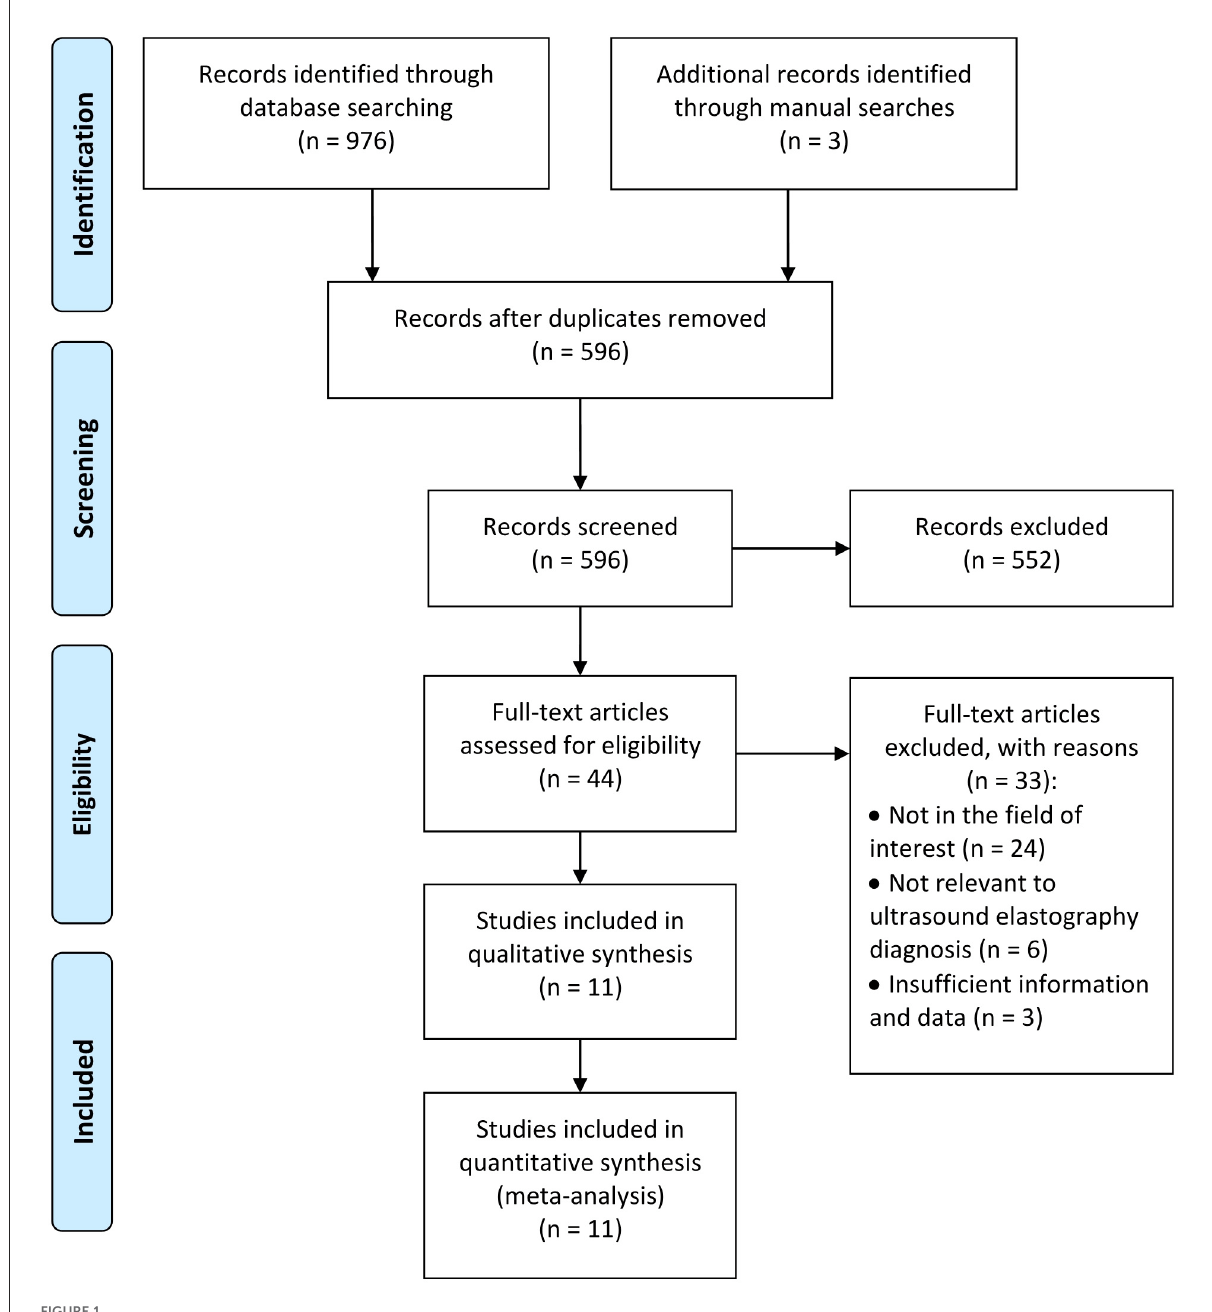
FIGURE1 Flow diagram of the